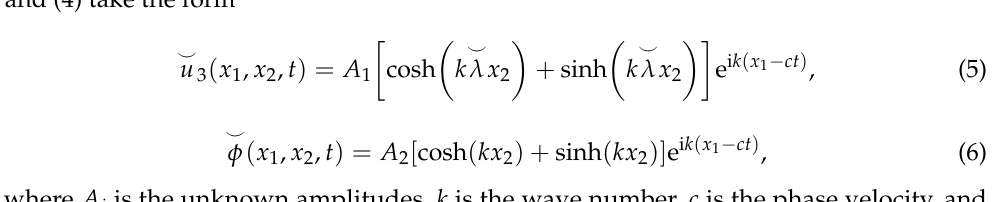
  φ u and satisfying Equations 3